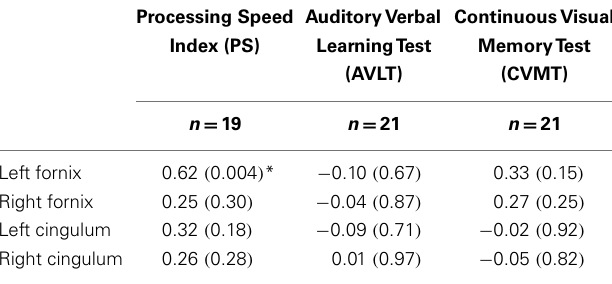
Table 2 | Spearman rho correlations of neuropsychological test scores and fractional anisotropy (FA) of the fornix and cingulum inTLE patients